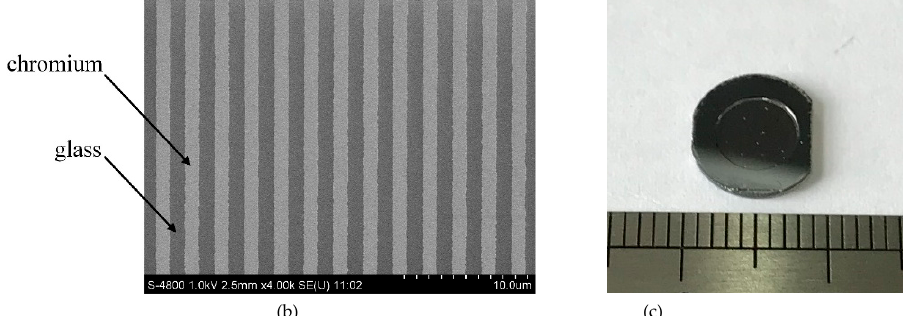
Figure 3. Photographs of the fabricated samples: ( a ) the etched cavity; ( b ) the micro grating; ( c ) the sensor chip.